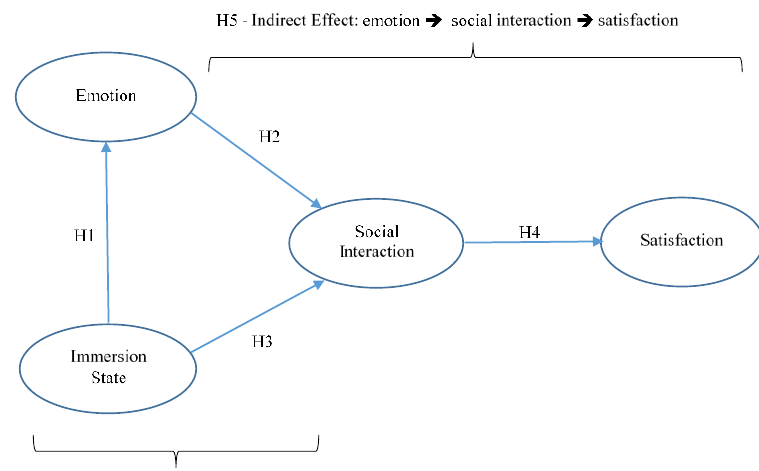
Figure 1: Theoretical Model and